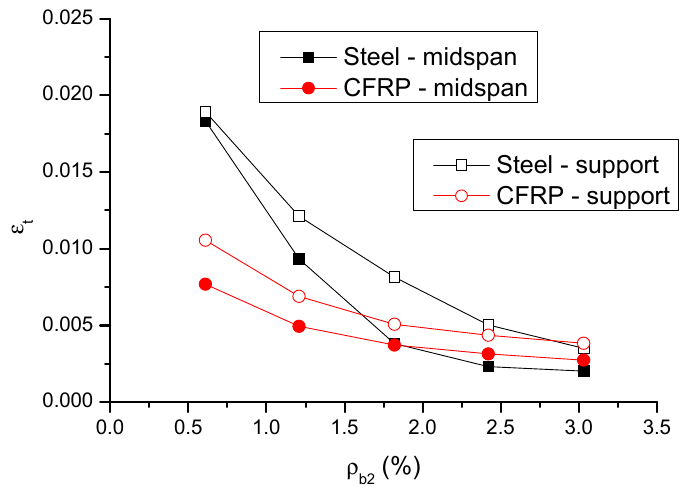
Figure 13. Variation of ultimate bar strain with varying bar ratio.